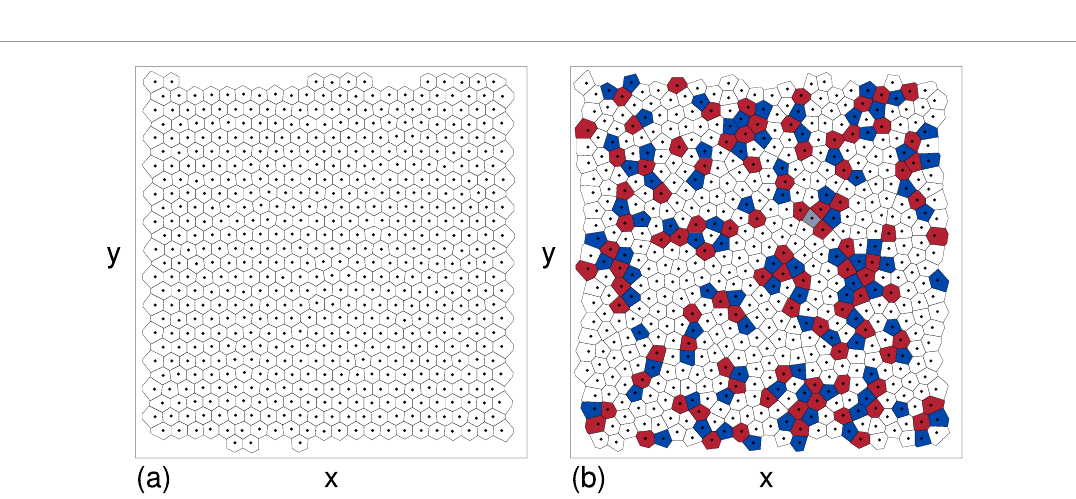
Figure 3. Voronoi construction of the electron positions for the system in figure 2(a) with no quenched disorder, σ = 0. White polygons are sixfold coordinated, blue are fivefold coordinated, red are sevenfold coordinated, and gray are fourfold coordinated. (a) At T / T m = 0 . 52 the lattice is triangular. (b) At T / T m = 1 . 09, numerous topological defects have appeared and the system is in a liquid